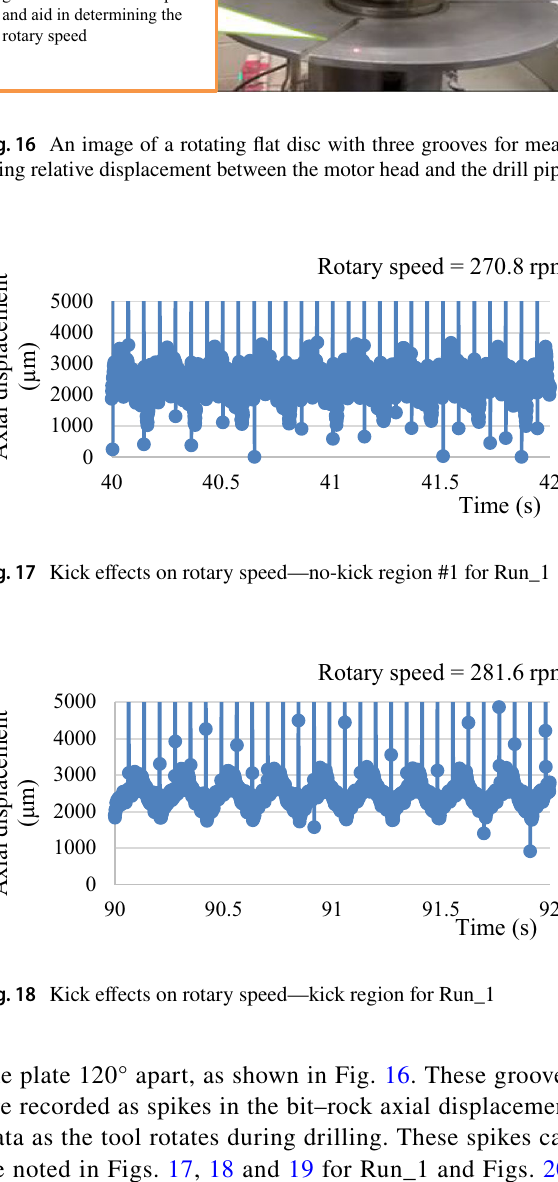
Rotating flat disc with three grooves that record as spikes and aid in determining the rotary speed